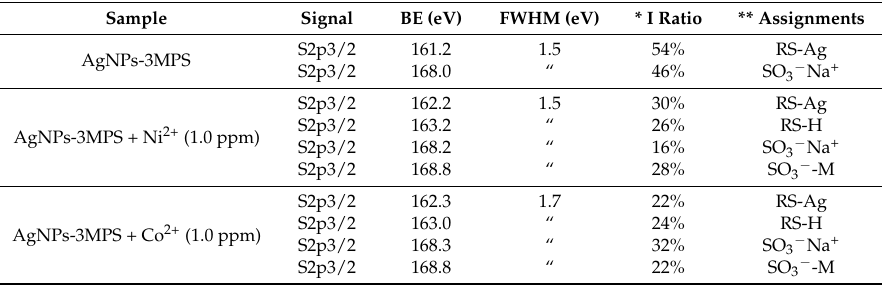
Table 3. HR-XPS S2p core levels data collected on silver nanoparticles (NPs) stabilized by 3MPS (BE, FWHM, atomic ratio, and assignments) and AgNPs-3MPS in presence of nickel and cobalt ions (1.0